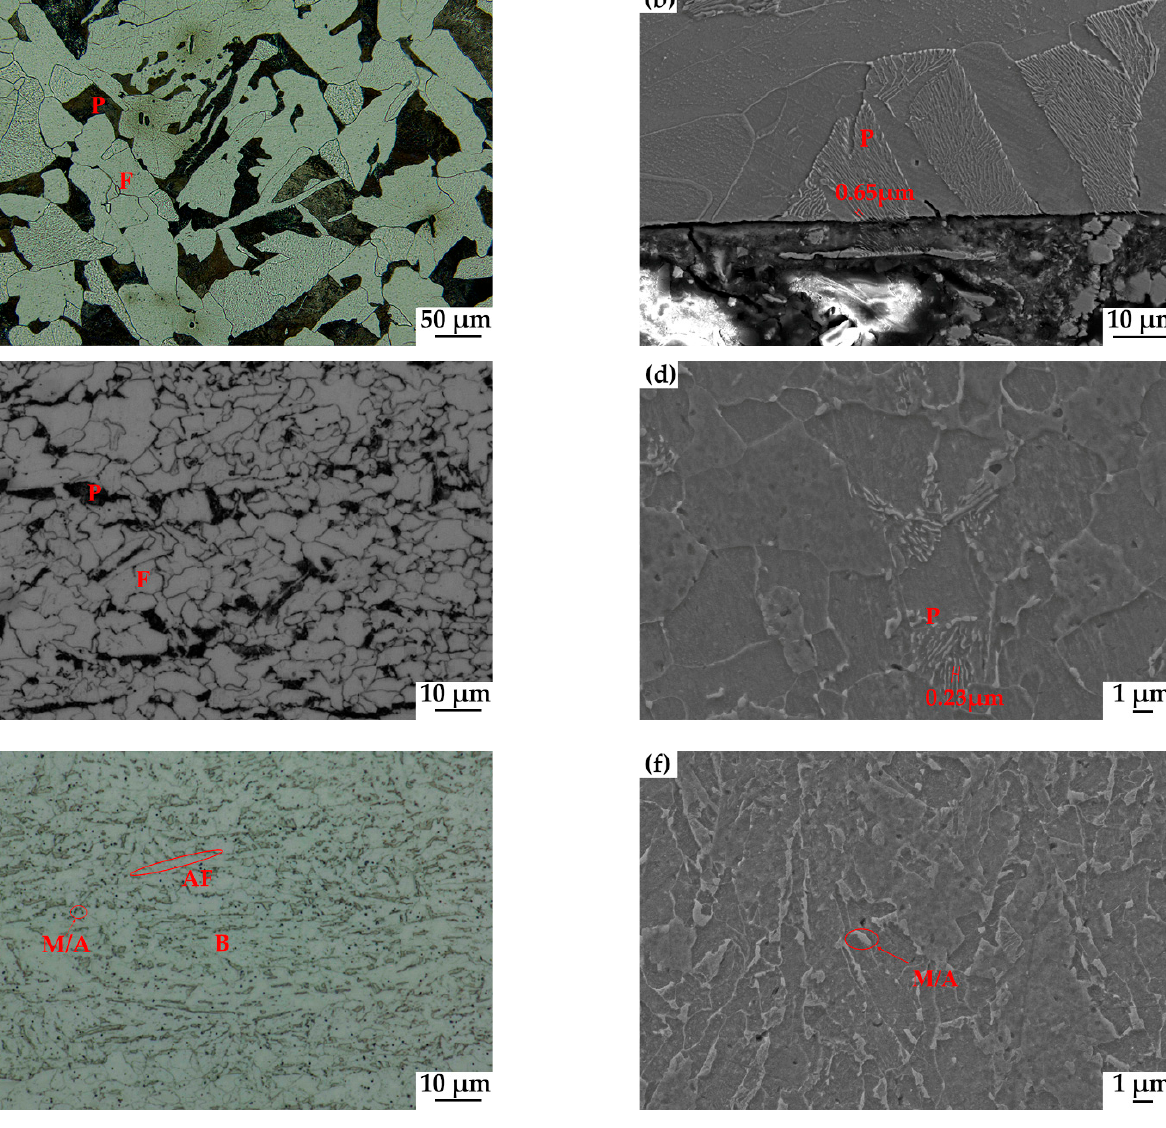
Figure 2. Microstructures of 20# ( a , b ), X60 ( c , d ), and X80 ( e , f ) steel. (P: Pearlite; F: Ferrite; B: Bainite; AF: Acicular Ferrite; M/A: Martensite/Austenite).